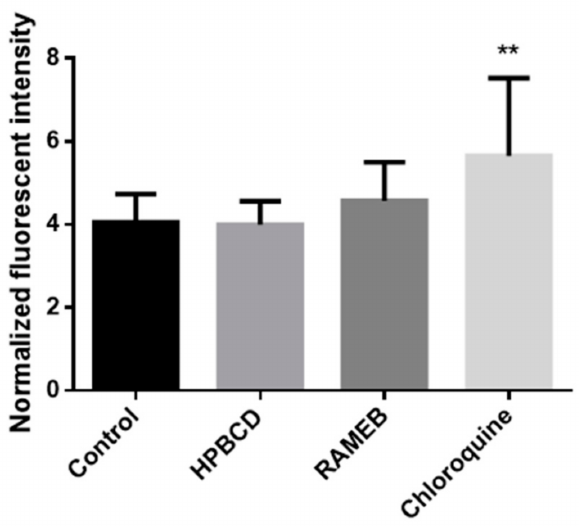
Figure 7. Effects of HPBCD, RAMEB and chloroquine treatments on autophagy. Cyclodextrin treatments did not increase the autophagosome formation compared to the control sample, while the chloroquine treatment significantly increased the formation. Results were normalized to the cell number and expressed as normalized fluorescence intensity. Results are expressed as means ± S.D. ** p < 0.01 vs.